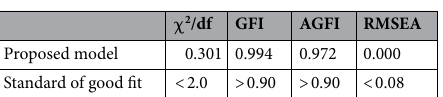
Table 1. Fit indices of SEM, which show that our model closely fits the